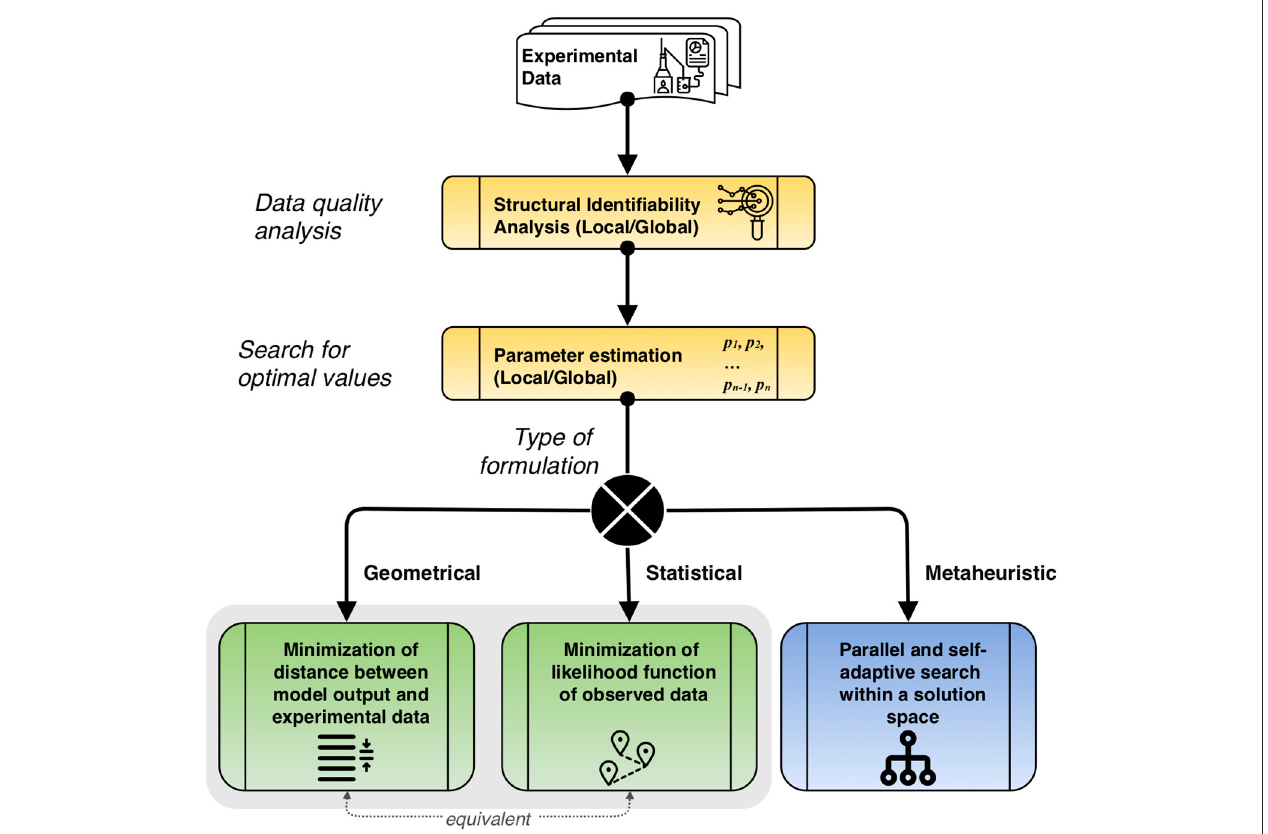
FIGURE 3 | Description of the overall parameter estimation procedure. First, quality of experimental data is studied to determine suitable parameters via structural identifiability analysis. Then, parameter estimation is performed, locally or globally, according to the type of problem formulation. The equivalence between the geometrical and statistical formulations is